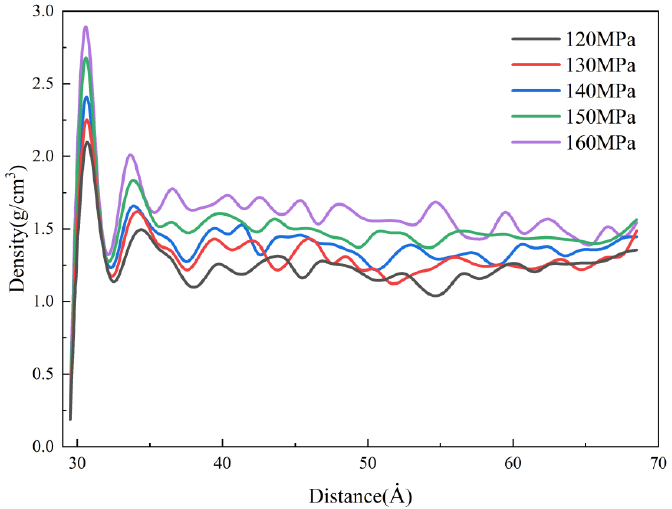
Figure 16. Density distributions at different packing pressures along the flow direction.